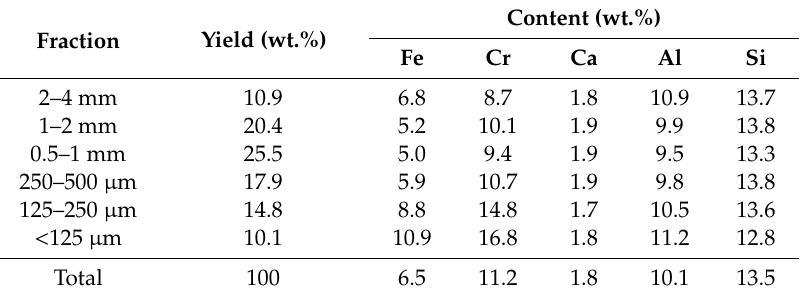
Table 4. Chemical composition of di ff erent size fractions after sieving (HC FeCr